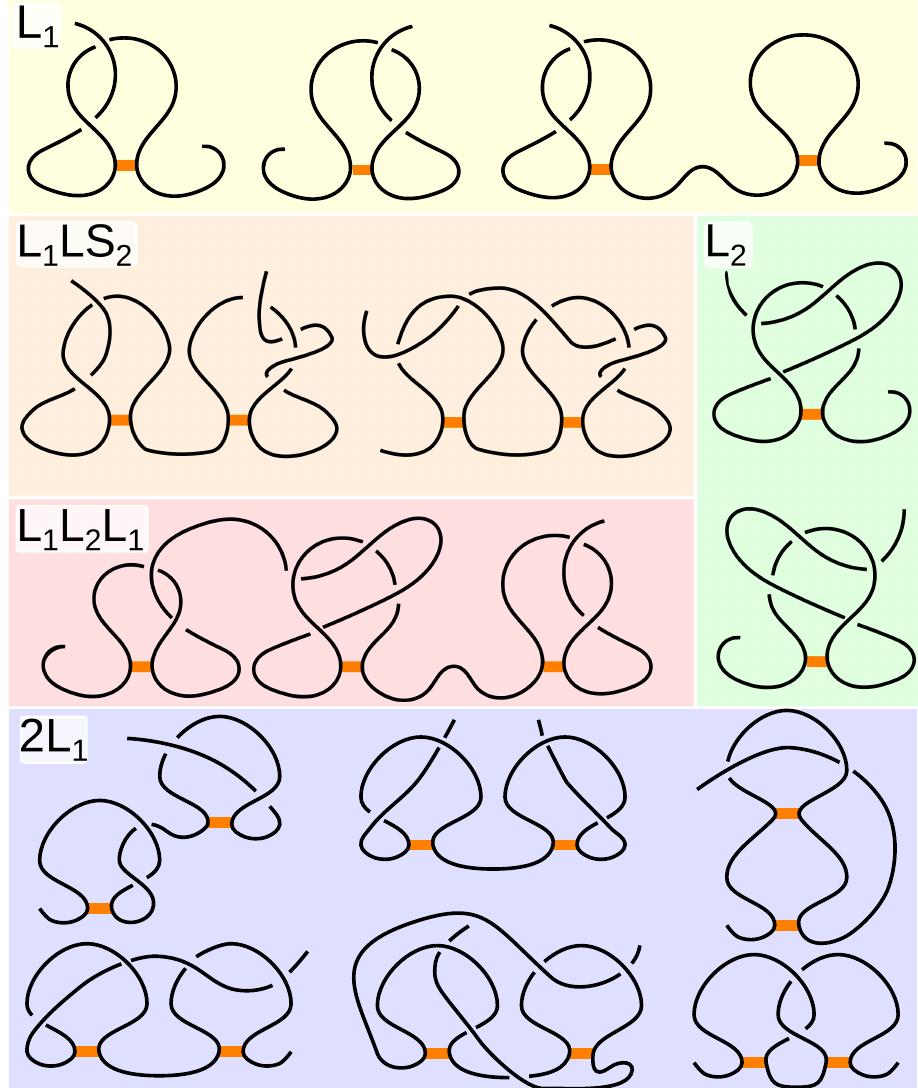
Figure 5. Exemplary lasso structures with fingerprints prescribed. The color boxes contain structures with the same fingerprint. The fingerprint is shown in the upper left corner of the box. The bridge is denoted with an orange strip. Note that by taking into account the piercing tail and orientation, the number of the structures in the Figure multiplies. Note also that the covalent loops in the bottom right structure are linked. Note that the structure over it has one big and one small covalent loop, both being pierced in the same